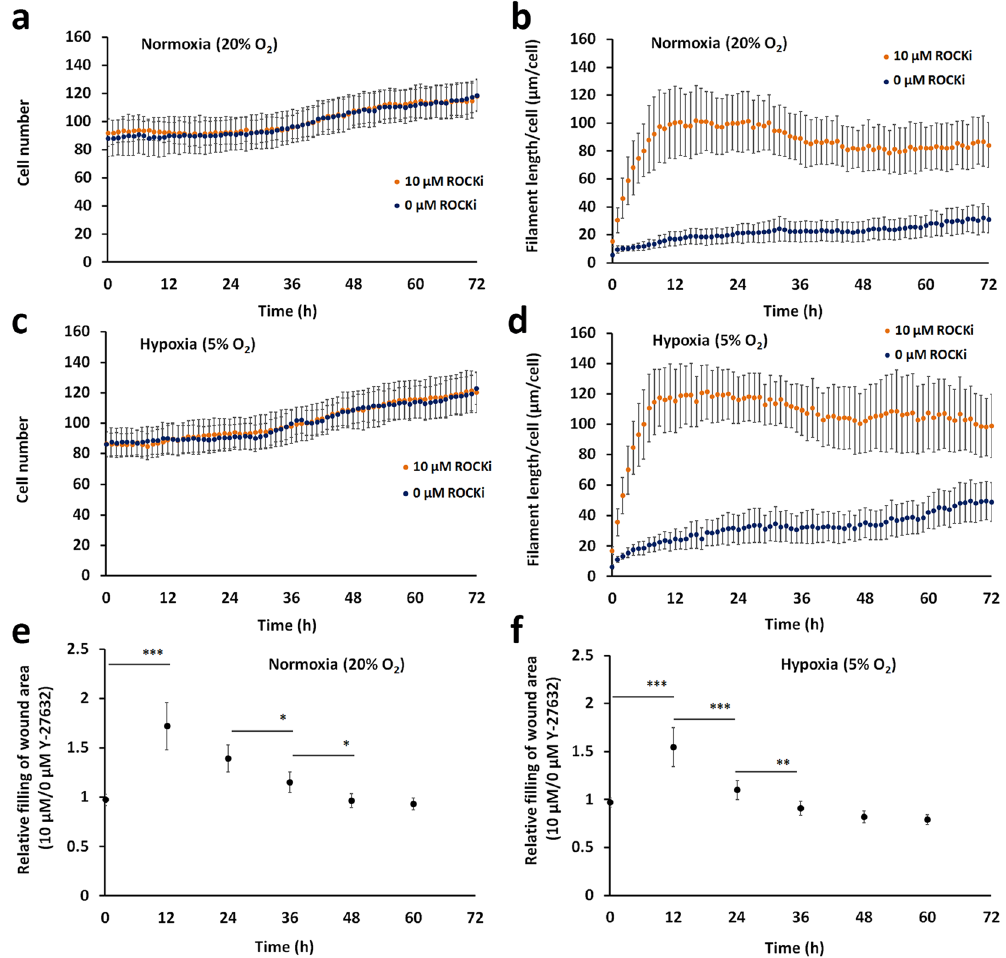
Figure 1. Cell-IQ time-lapse imaging assay. The cell number and the average filament length of control and 10 µ M Y-27632-treated cells at normoxia ( a and b ). The cell number and the average filament length of control and 10 µ M Y-27632-treated cells at hypoxia ( c and d ). The relative filling of the wound area of Y-27632-treated cells vs . controls at normoxia ( e ) and at hypoxia ( f ). Rho-kinase inhibitor induced a short transient increase in filling rates at both oxygen atmospheres. Cell monitoring was repeated three times with at least two replicates and the scratch wound assay was performed three times each with six